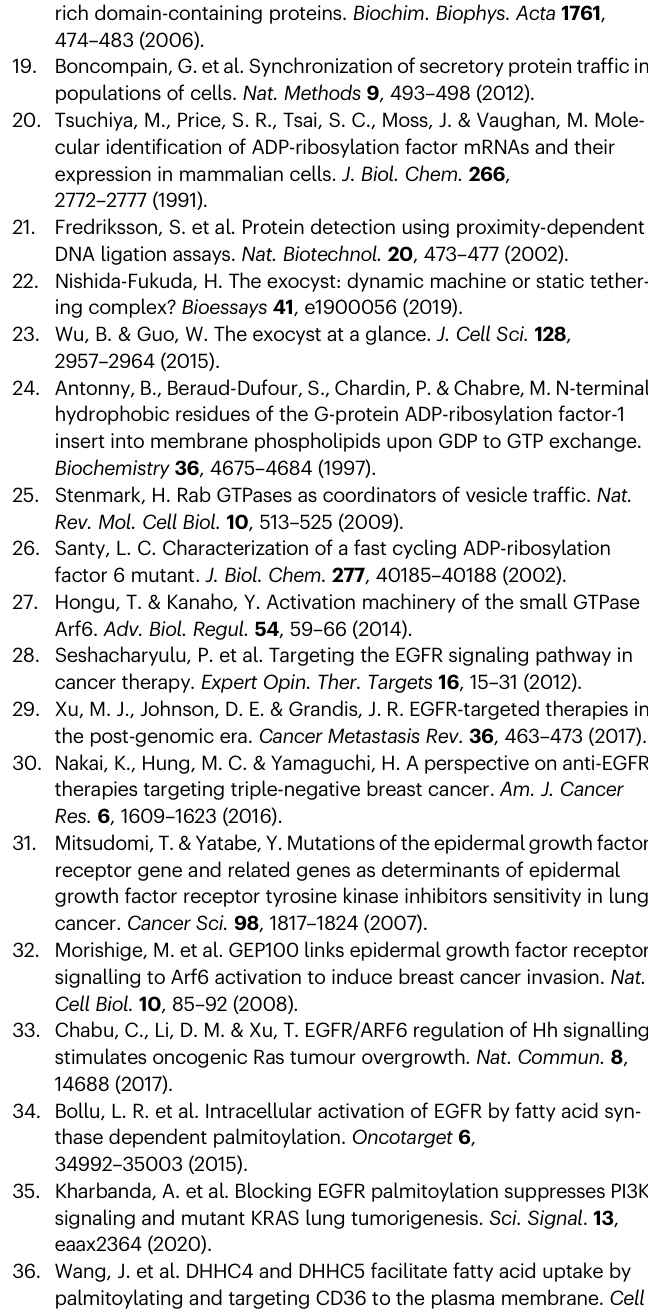
Fig. 7 | The Myristoylated GKVL-TAT peptide inhibits the growth of EGFR- overexpressiontumors.a , b Onday0,A549cellsweresetupasinFig.1a.Onday2, cellsweretreatedwith10 μ MMyr-GKVL-TATorGKVL-TATfor20h.Cellswerethen incubated with serum-free medium, including the peptides, for 4h. a Immunostaining assays were performed using the anti-EGFR antibodies. The upperpanelshowsthesequenceofthetwopeptides.Scalebar,20 μ m. b Cellswere treated with 100ng/ml EGF for the indicated time, harvested, and subjected to westernblot. c Onday 0,A549 cellswereset up at7×10 3 cells perwell in a 96-well plate. From day 1, cells weretreatedwith various concentrations ofMyr-GKVL-TAT or GKVL-TAT for two days. On day 3, cell viability wasdetermined by cell counting kit-8 (Topscience, C0005). Each value represents the mean±SEM of a triplicate. The statistical analysis was performed by a student ’ s two-tailed paired t -test. IC 50